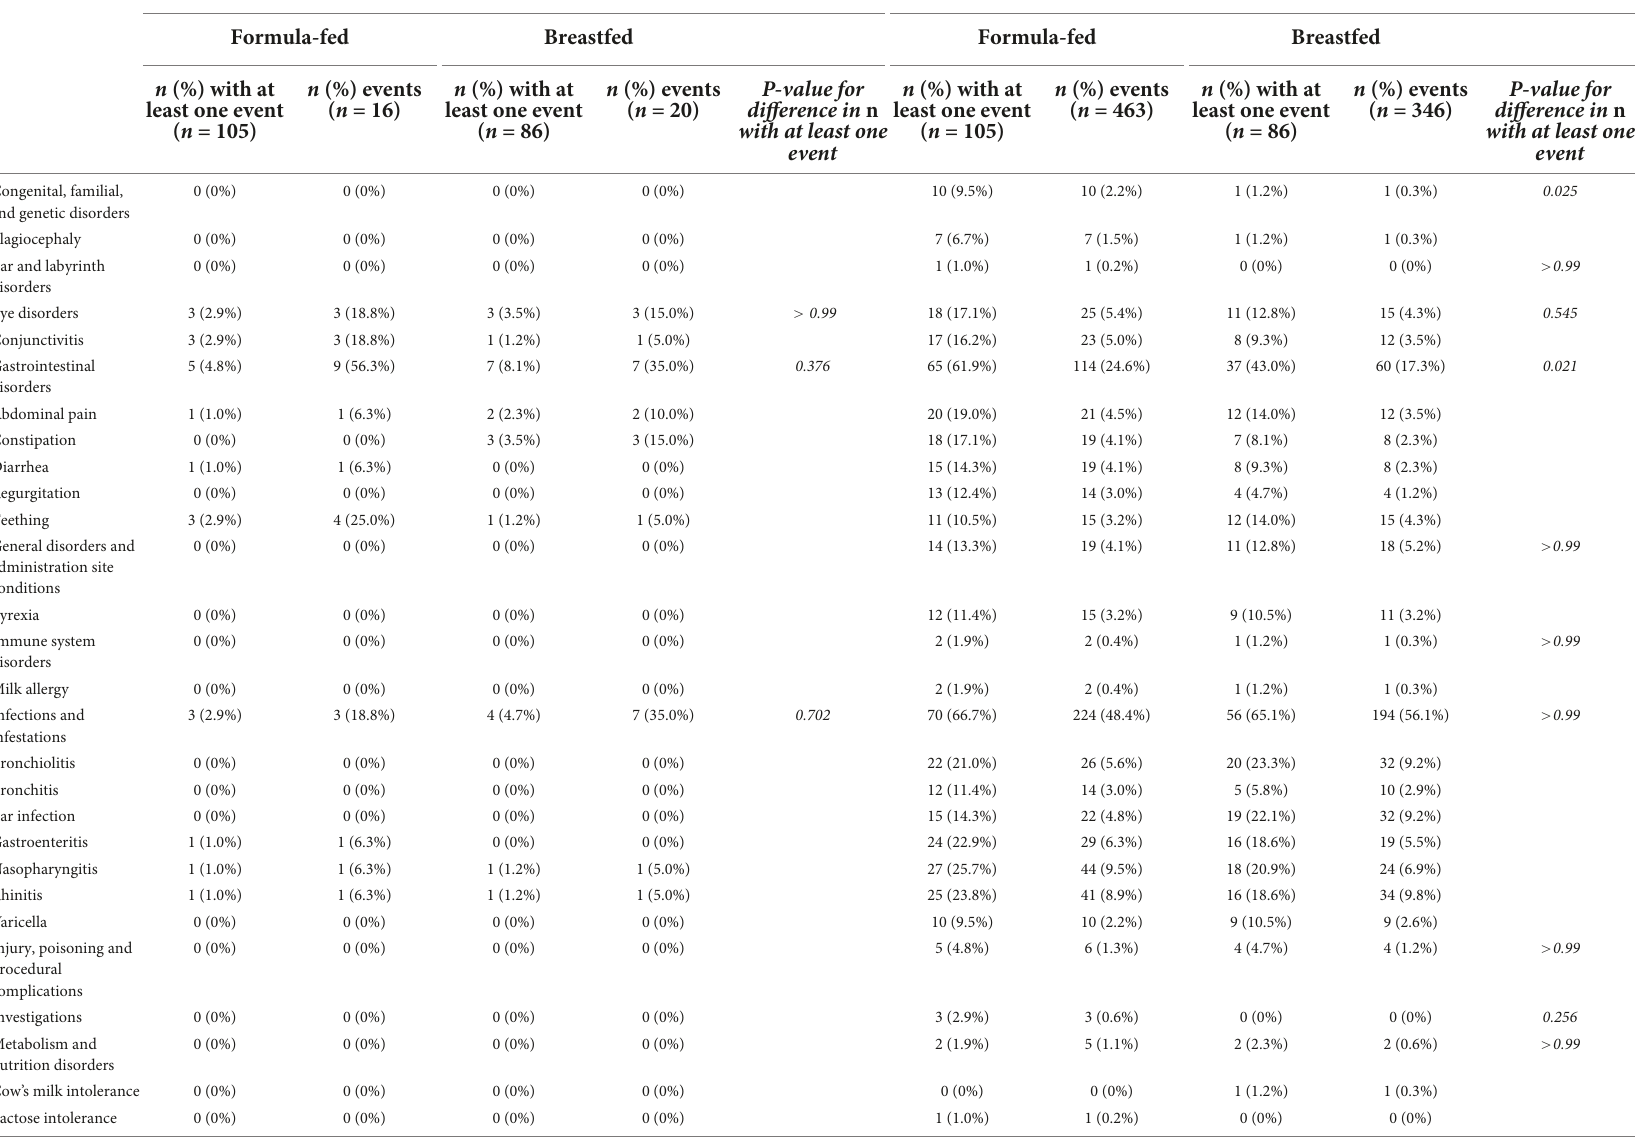
TABLE 5 Frequency of adverse events by system organ class and preferred term, by feeding group and time period.